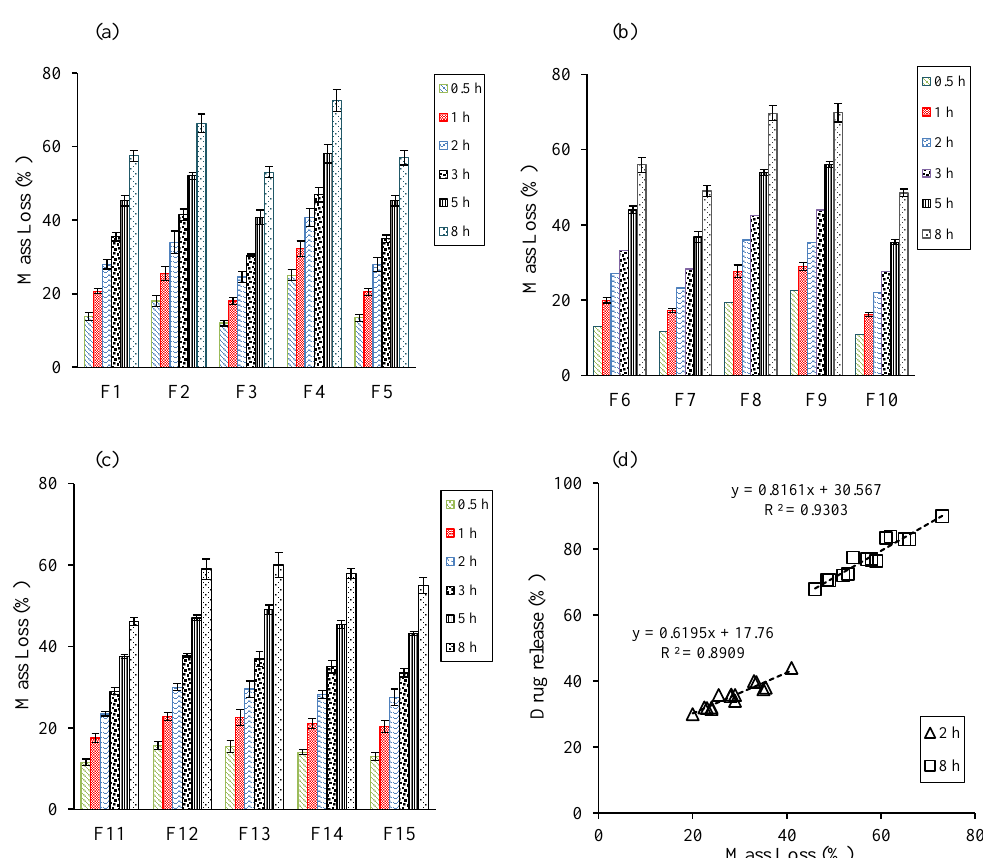
Figure 3. Figure 3. Plots of tablet matrix erosion (% mass loss) vs. time of various formulations based on the BBD experimental design, ( a ) F1–5, ( b ) F6–10, and ( c ) F11–F15). ( d ) Correlation between drug release rate and mass loss in different time points.